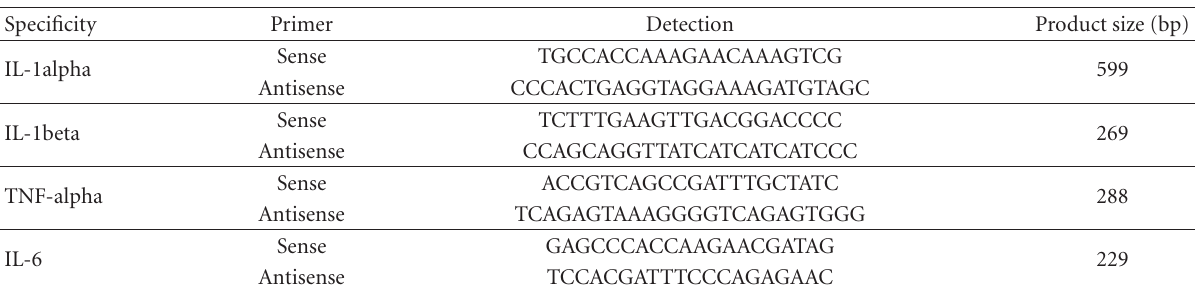
Table 1: Specific primers for the reverse transcriptase polymerase chain reaction (RT-PCR) and the predicted sizes of the PCR products